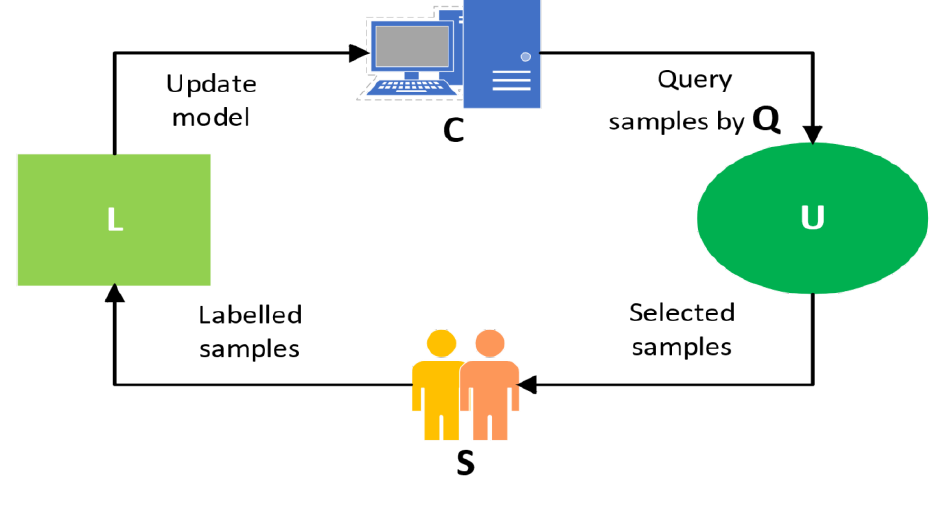
Figure 2. Active Learning Framework.